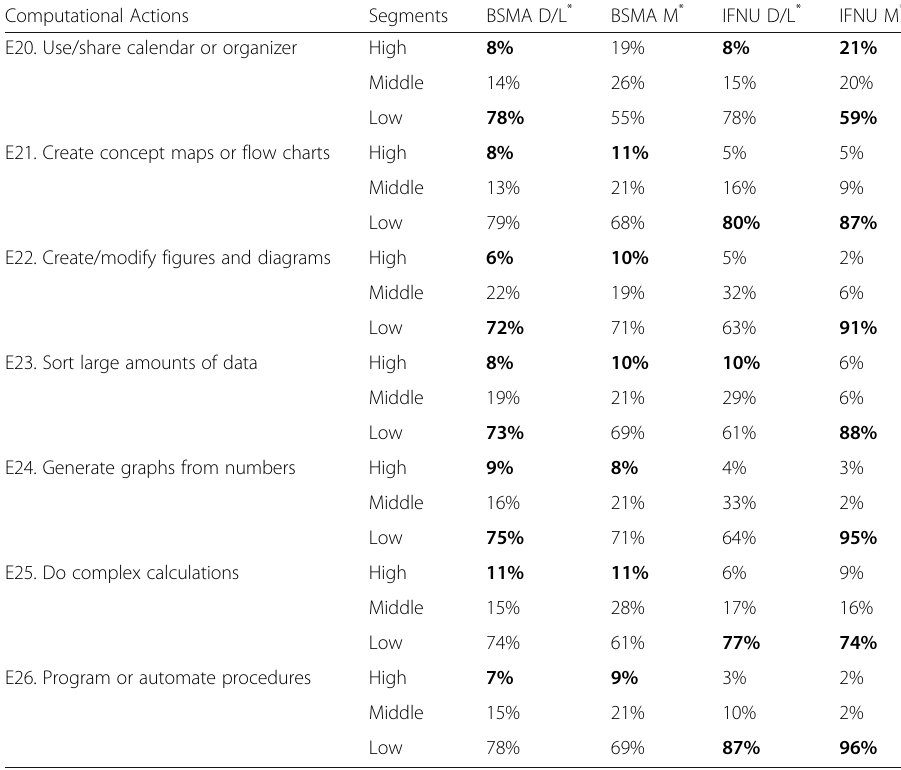
Table 5 Digital readiness segments for computational actions Computational